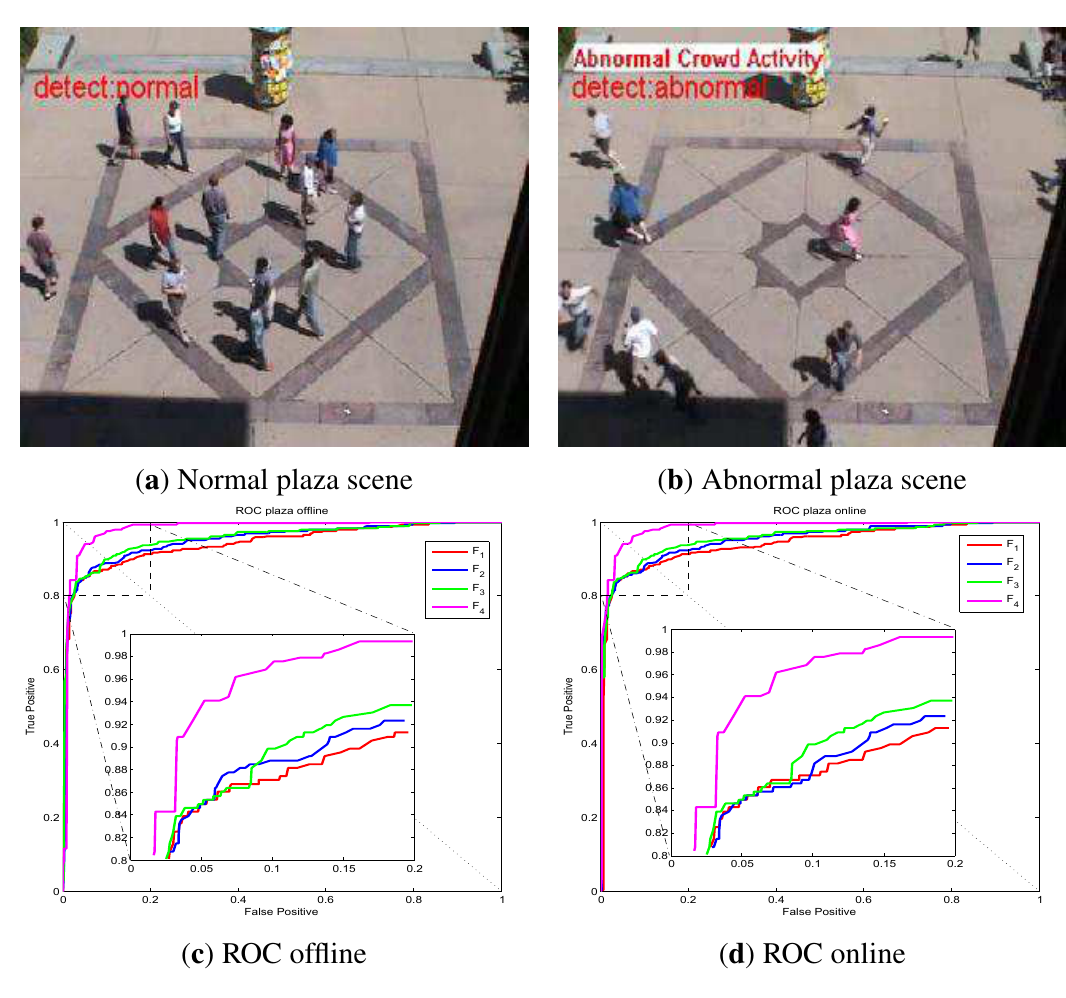
Figure 9. Detection results of the plaza scene. ( a ) The detection result of a normal frame; ( b ) The detection result of an abnormal panic frame; ( c ) ROC curve of covariance descriptors constructed from different features F of the plaza scene results via LS-OC-SVM. All the training samples are learned together offline. The biggest AUC value is 0.9800; ( d ) ROC curve of detection results via online LS-OC-SVM. The biggest AUC value is